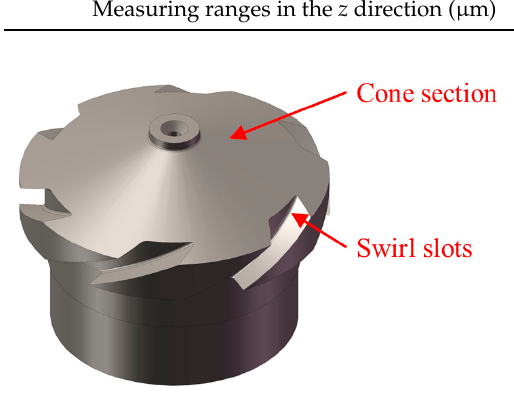
Figure 11. Inner part of a dual-orifice pressure-swirl nozzle. Figure 11 . Inner part of a dual ‐ orifice pressure ‐ swirl nozzle. Figure 11 . Inner part of a dual ‐ orifice pressure ‐ swirl nozzle.